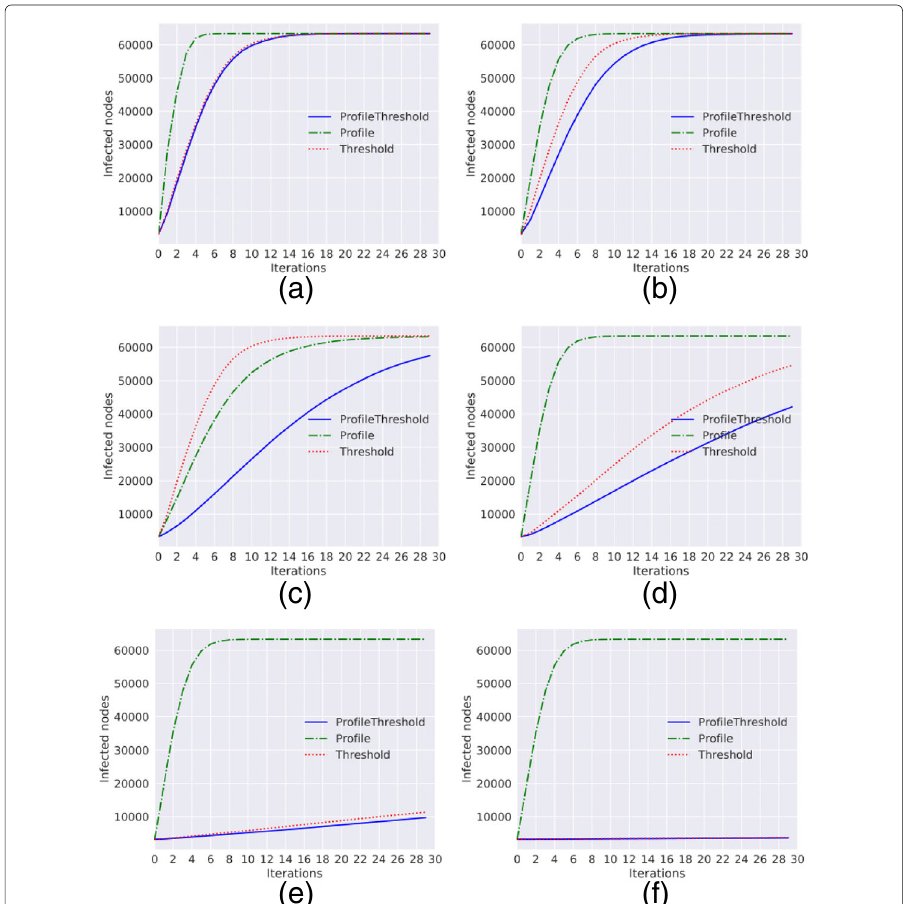
Fig. 3 Diffusion trends for the Wats-Strogatz graph. Diffusion trends for Threshold , ProfileThreshold and Profile model with a = 0 and p = 0 and with different values of γ and τ . a γ = 0.1, τ = 0.1 b γ = 0.4, τ =